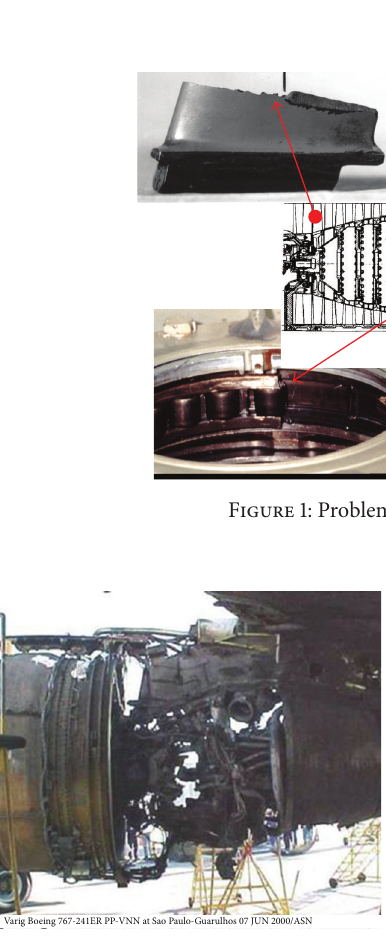
Figure 2: CF6-80 engine: fatigue destruction of III–IX stages of HP compressor